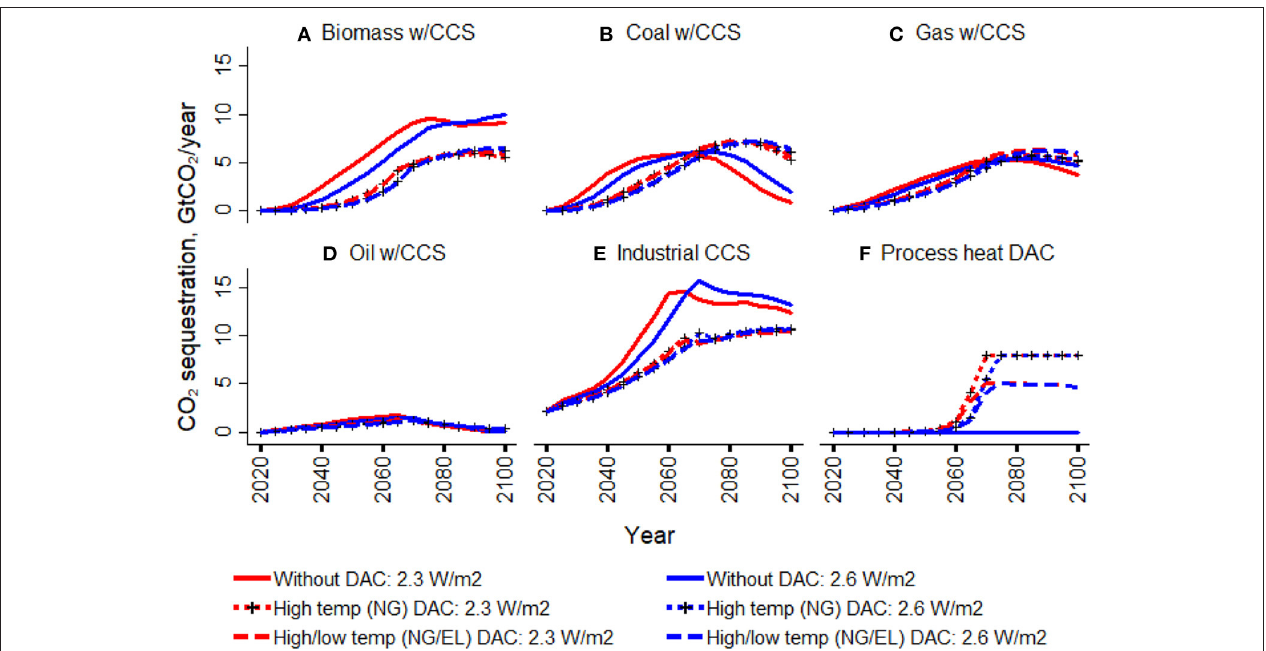
FIGURE 3 | CO 2 sequestration under the least cost strategy scenarios that aim to achieve climate mitigation goal by limiting the total radiative forcing to 2.3 W/m 2 by year 2100 (shown in red color) and 2.6 W/m 2 by year 2100 (shown in blue color), respectively. The scenario “Without DAC” includes only BECCS and AR, the scenario “High temp (NG) DAC” includes a high temperature natural gas-based DAC in addition to BECCS and AR, and the scenario “High/low temp (NG/EL) DAC” includes three types of DAC (high temperature natural gas-based DAC, high temperature electricity-based DAC and low temperature electricity-based DAC) in addition to BECCS and